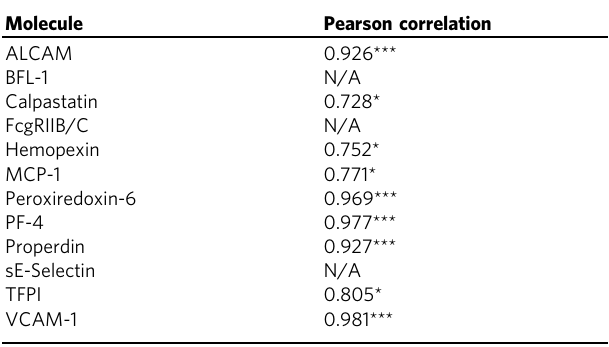
Table 1 Correlation between aptamer screen and ELISA assay results.